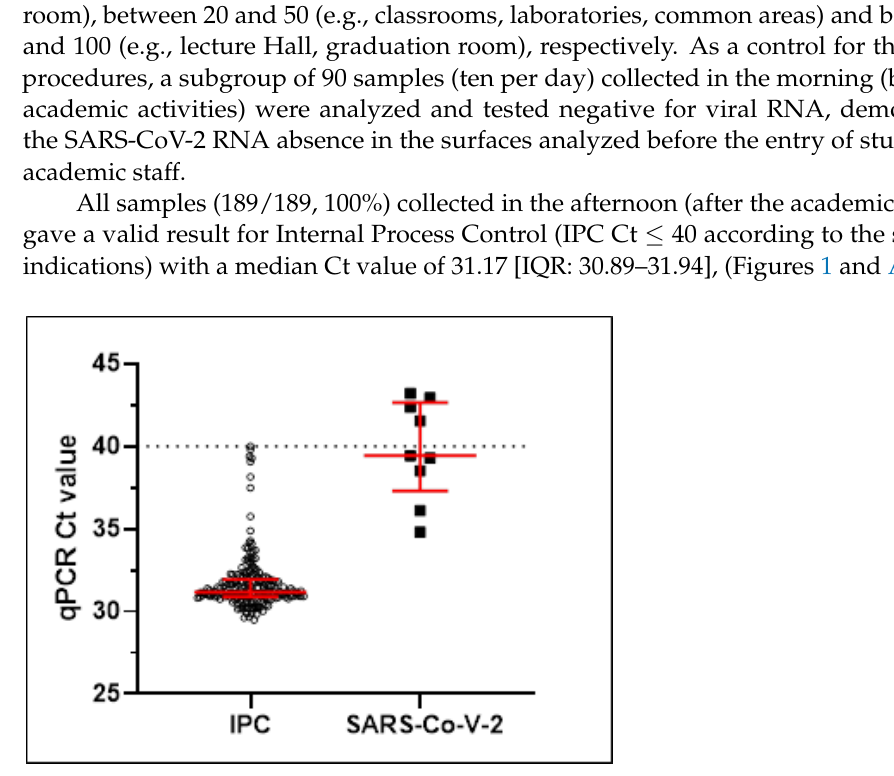
Figure 1. Results from qPCR in 189 environmental samples; all samples gave a valid Ct value (≤40, dotted line) for the Internal Process Control (IPC), and 9 gave a positive amplification for RdRp gene of SARS-CoV-2 RNA. Red lines represent the median and 25th to 75th percentiles. Nine samples tested positive for SARS-CoV-2 RNA (9/189, 4.8%; Figure 2) and gave a Ct value for the RdRp gene (median [IQR] 39.44 [37.31-42.66]) (Figure 1 and Table 1).